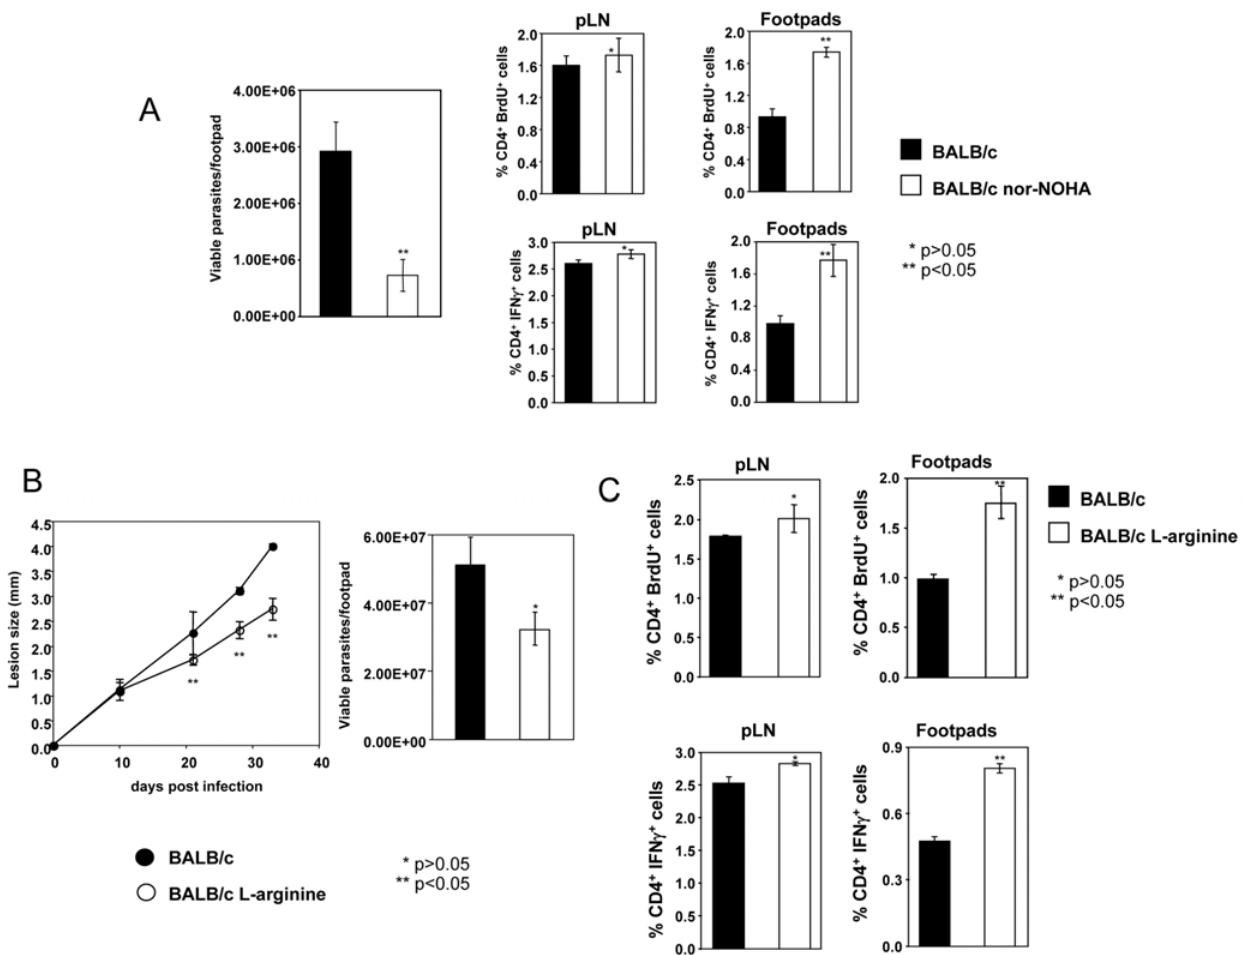
Figure 5. Interfering with arginase-induced L-arginine metabolism restores CD4 + T cell responses in nonhealer BALB/c mice. (A) Two groups of BALB/c mice (n=8) were infected with L. major parasites and one group was injected daily i.p. with a competitive inhibitor of arginase (nor- NOHA, 1 mg/mouse) starting from the day of infection. Two weeks later, the number of viable parasites was measured in individual footpads (left panel) and the % of CD4 + BrdU + T cells and IFN- c -expressing CD4 + T cells was determined by flow cytometry in popliteal lymph nodes and lesions (pool of at least 2 footpads). Error bars represent standard deviations. Data show the results of one representative experiment out of two independent experiments. (B) Two groups of BALB/c mice (n=8) were infected with L. major parasites in one hind footpad and 2 weeks post infection, one group was injected i.p. with L-arginine (10 mg/mouse) 3 times a week, for 3 weeks. The lesion development was monitored at weekly intervals (left panel) and 33 days post infection, number of viable parasites and the arginase activity was measured in individual footpads (right panel). (C) % of CD4 + BrdU + T cells and IFN- c -expressing CD4 + T cells in popliteal lymph nodes and lesions (pool of at least 2 footpads), error bars represent standard deviations. Data show the results of one representative experiment out of four independent